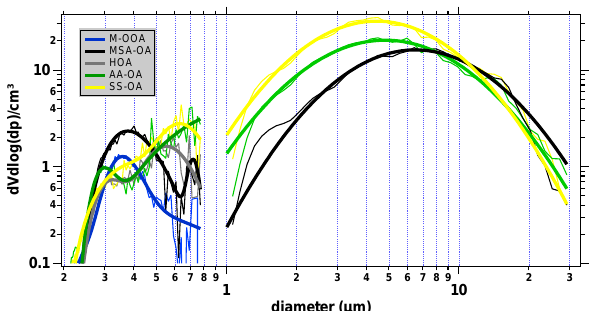
Fig. 6. Volume size distributions derived for individual PMF OA factors by the SMPS (a) and APS (b) . The data were extracted from the time periods during which the respective factors dominated the submicron organic mass (>66%, and 50% for SS-OA), indicated by the red bars in Fig. 5b. The thinner lines represent the actual data, while the thicker lines show the fits to the data (see Table